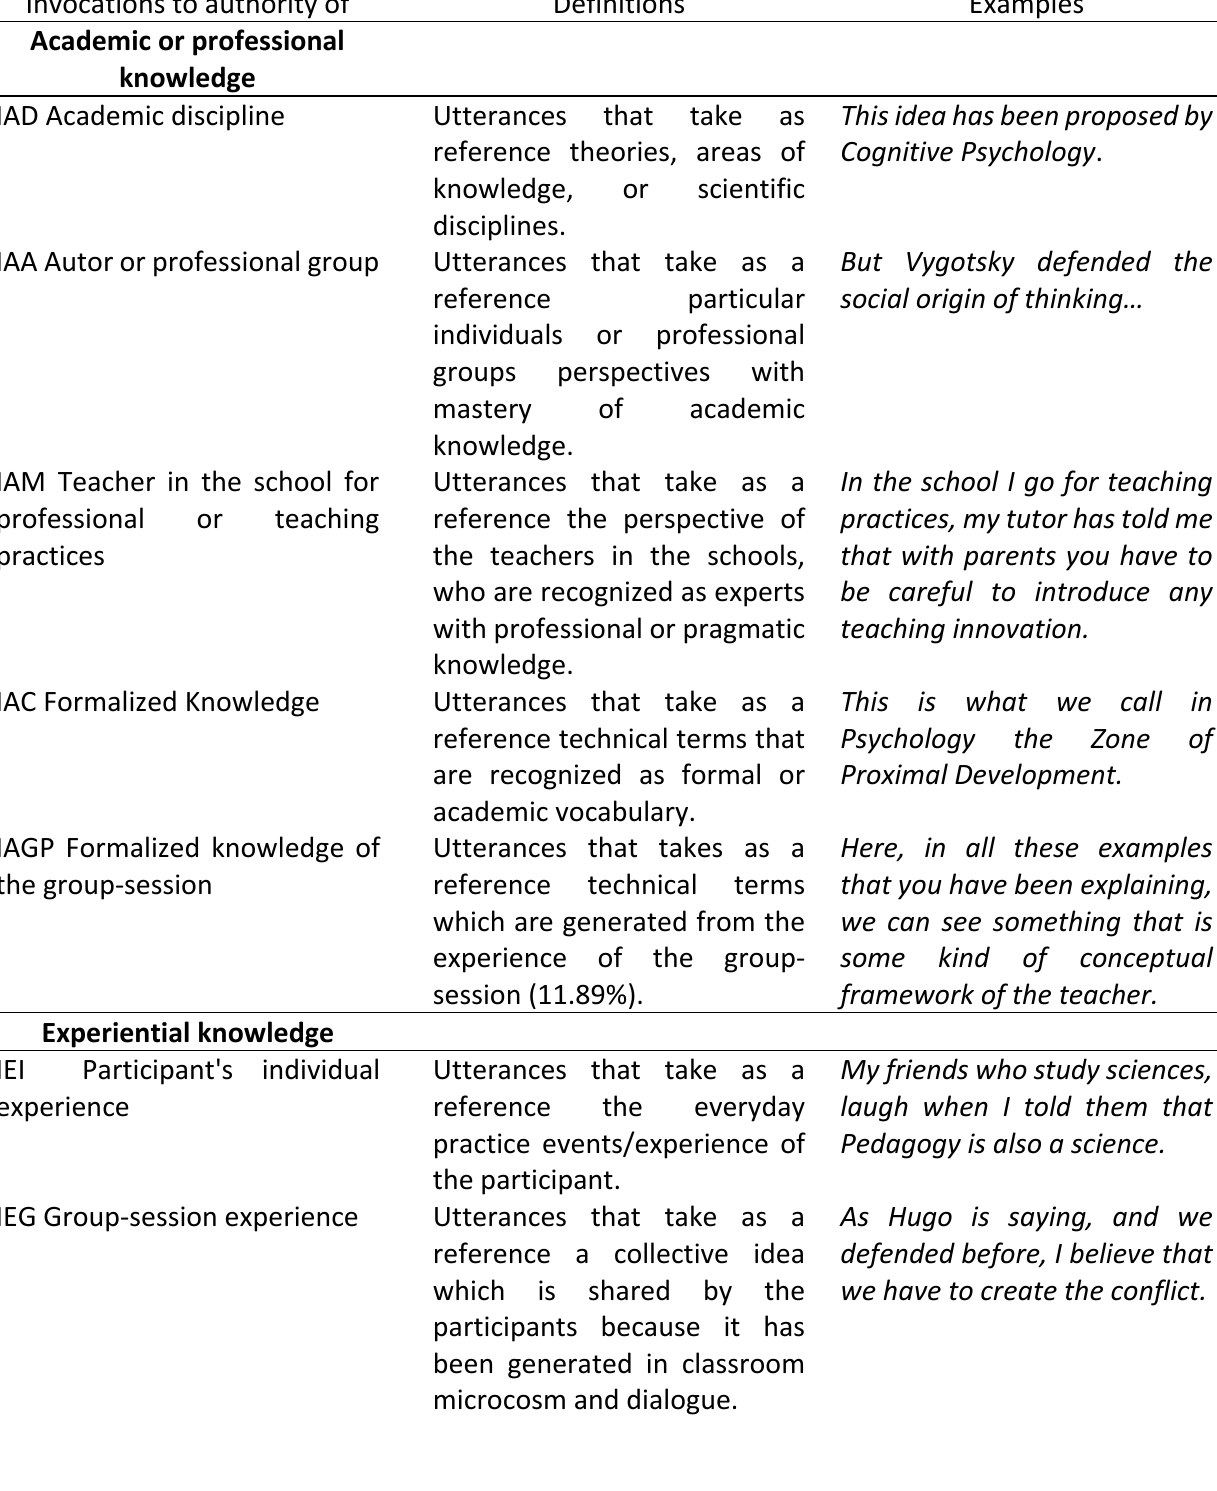
Table 2. Invocations or knowledge validation sources categories system (summary